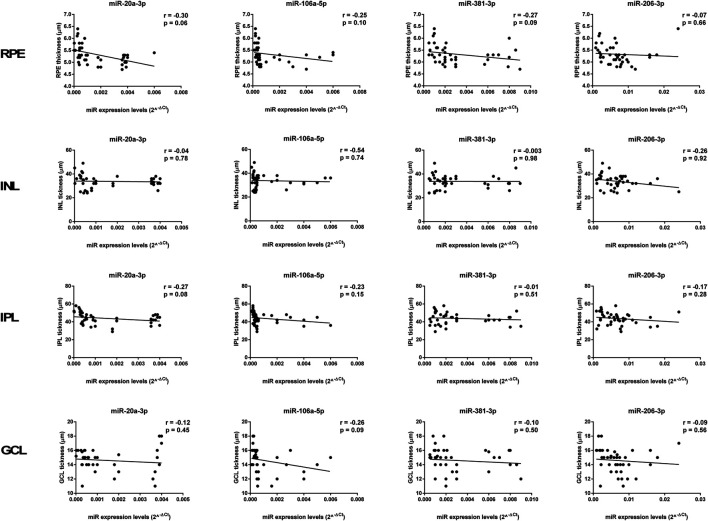
Age-related miRNA expression levels not correlated with retina structure. No significant correlations were observed between RPE, INL, IPL, and GCL thickness and the miR-20a-3p, miR-106a-5p, miR-381-3p, and miR-206-3p expression levels. Pearson correlation analysis was used to evaluate the strength of association between pairs of variables, by including all the samples with different age and gender. Differences were considered statistically significant for p values <0.05. RPE, retinal pigment cells; INL, retinal inner nuclear layer; IPL, retinal inner plexiform layer; GCL, retinal ganglion cell layer.